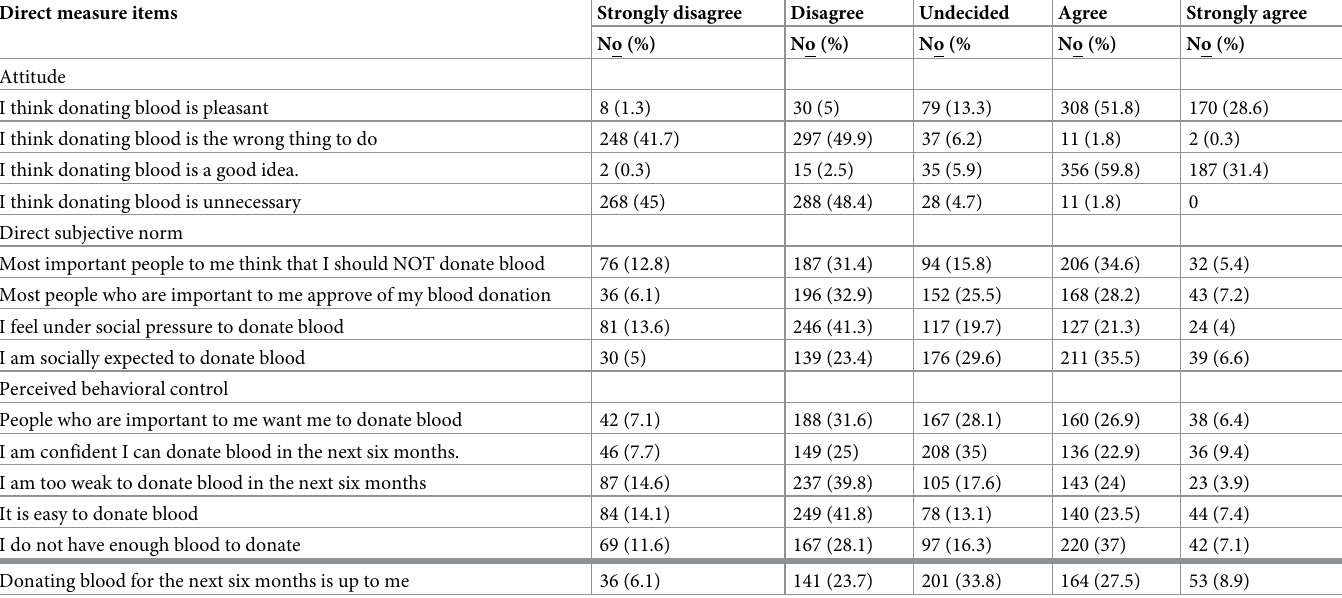
Table 4. Frequency of direct TBP constructs among respondents in Jimma Town, Oromia,